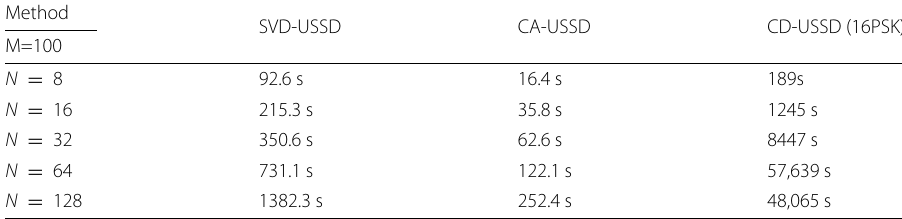
Table 3 Runtime of SVD-USSD, CA-USSD, and CD-USSD algorithms Method SVD-USSD CA-USSD N =